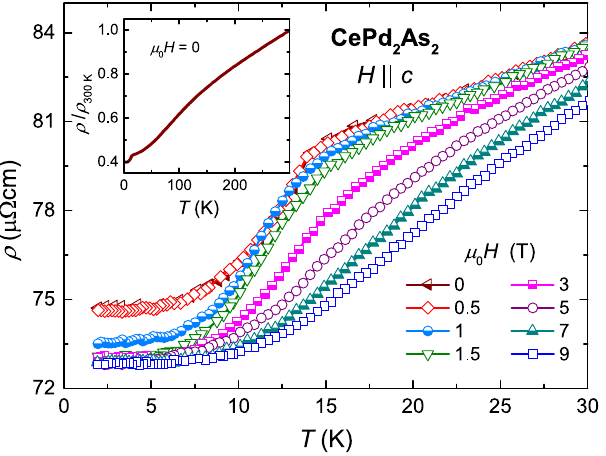
Figure 5. Temperature dependence of electrical resistivity ρ ( T ) of CePd 2 As 2 measured at various magnetic fields applied along the c -axis. Inset: normalised resistivity ρ / ρ 300 K as a function of T